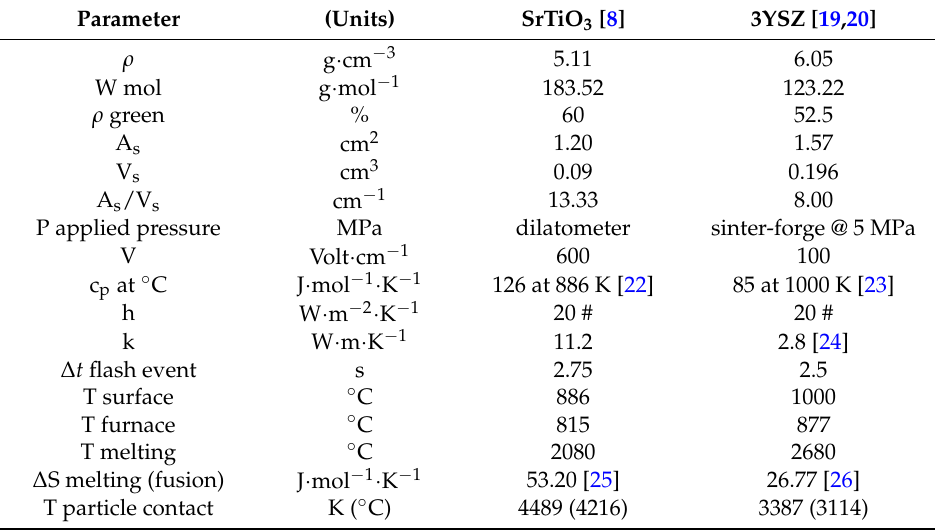
Table 1. Materials and process parameters for two flash sintered oxide